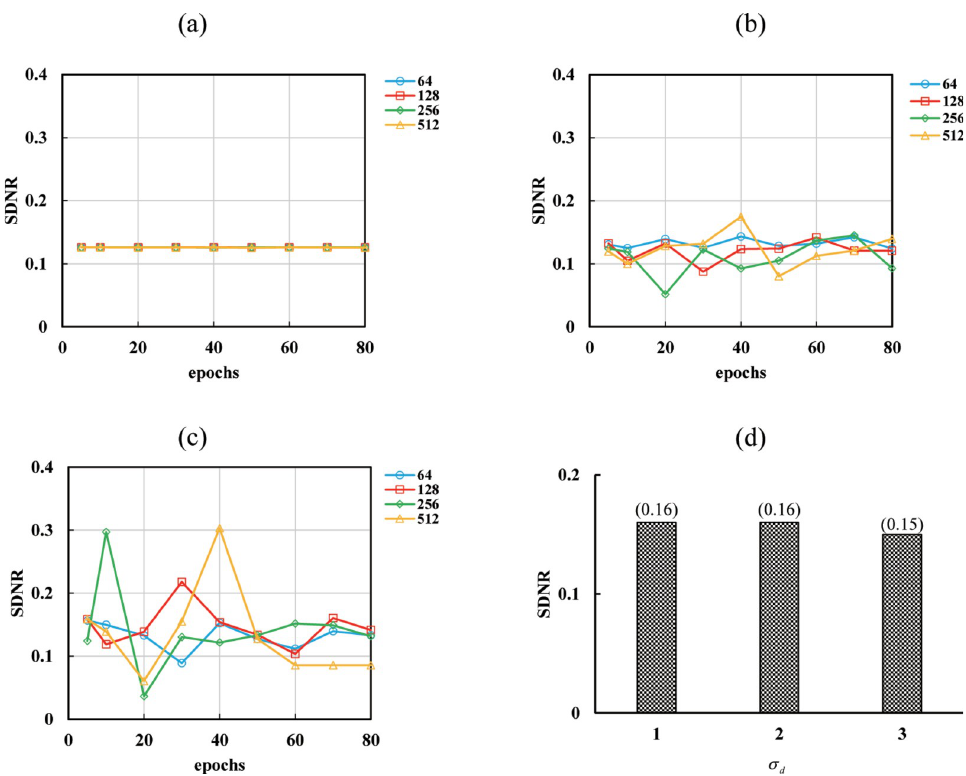
Fig 8. Optimization results for parameter [mini-batch, epochs, and standard deviation of domain filter σ determination. The signal-difference-to-noise ratio (SDNR) resulting from differences in the initial learning rate [(a): 0.1, (b): 0.01, and (c): 0.001], mini-batch, and epochs in the DE–VM with the very-deep super-resolution (VDSR) reconstruction algorithm (DE–VM–VDSR) are shown. (d) The SDNRs resulting from differences in σ